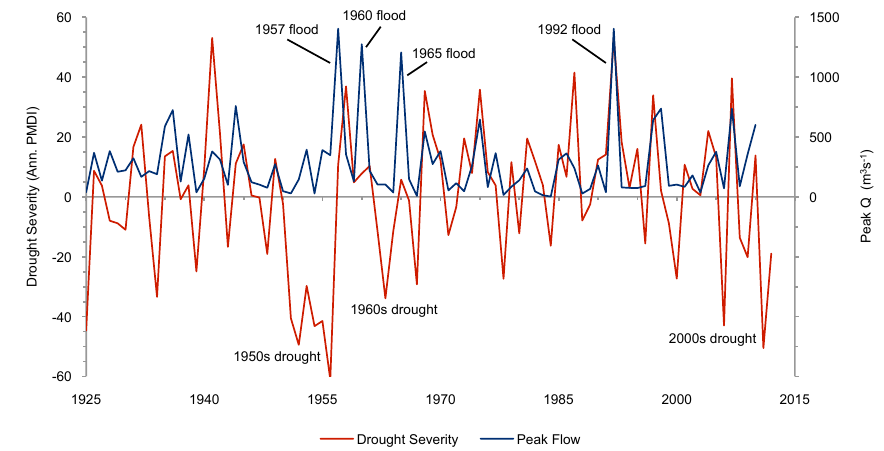
Figure 8. Chronology of regional drought (annual Palmer Modified Drought Index) and peak flows on the Lampasas